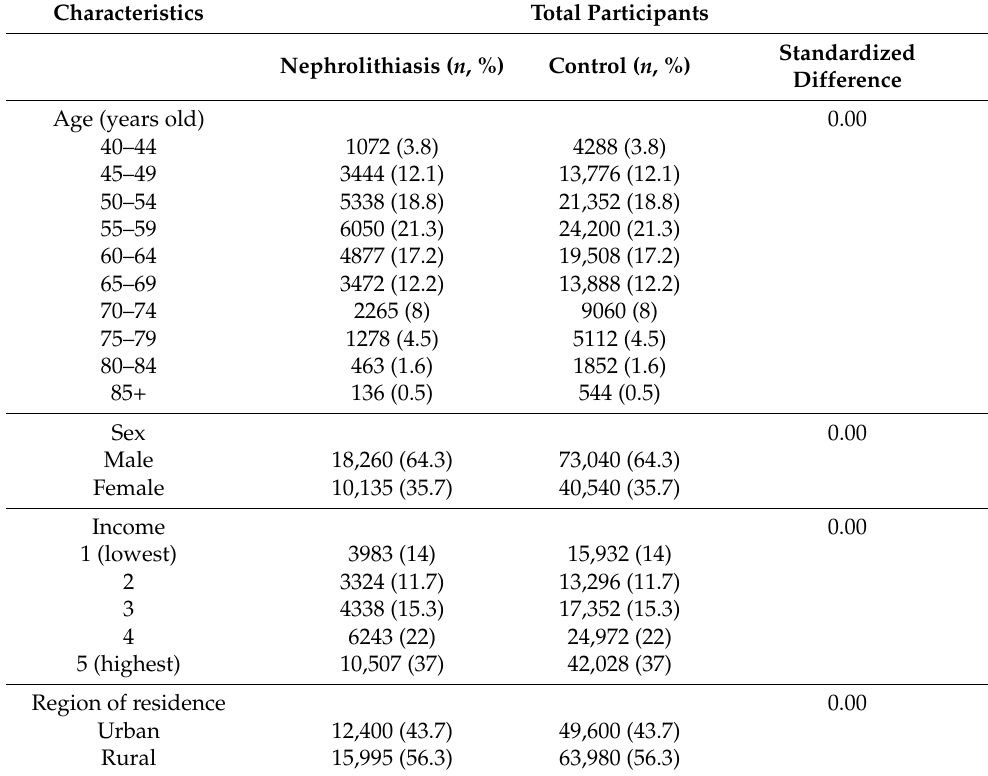
Table 1. General characteristics of participants.